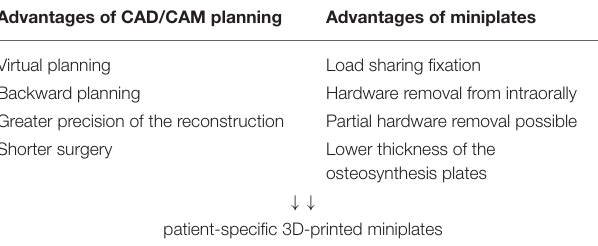
TABLE 4 | Advantages of 3D-printed